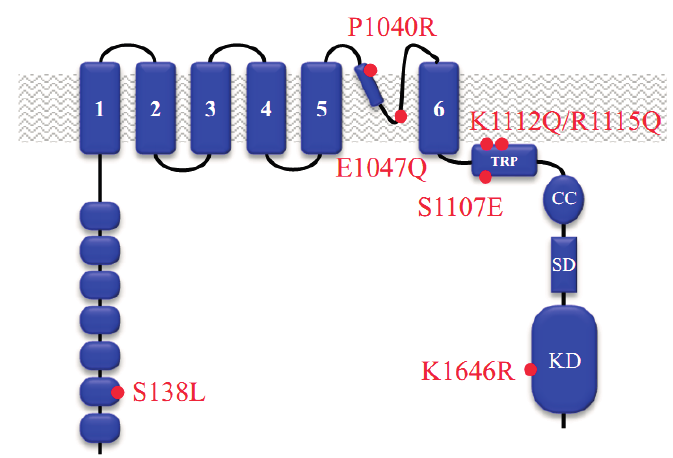
Figure 1. Domain topology of the murine kinase-coupled channel Transient receptor potential cation channel subfamily M member 7